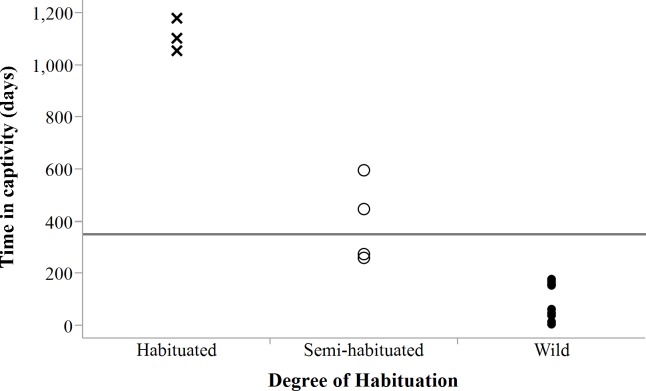
Degree of habituation to humans exhibited by cheetahs in relation to time in captivity.Horizontal line shows mean captive time (350.6 days ± 439.0 days SD) for all individuals (n = 23). Note: a datum may represent multiple individuals held captive for the same period.